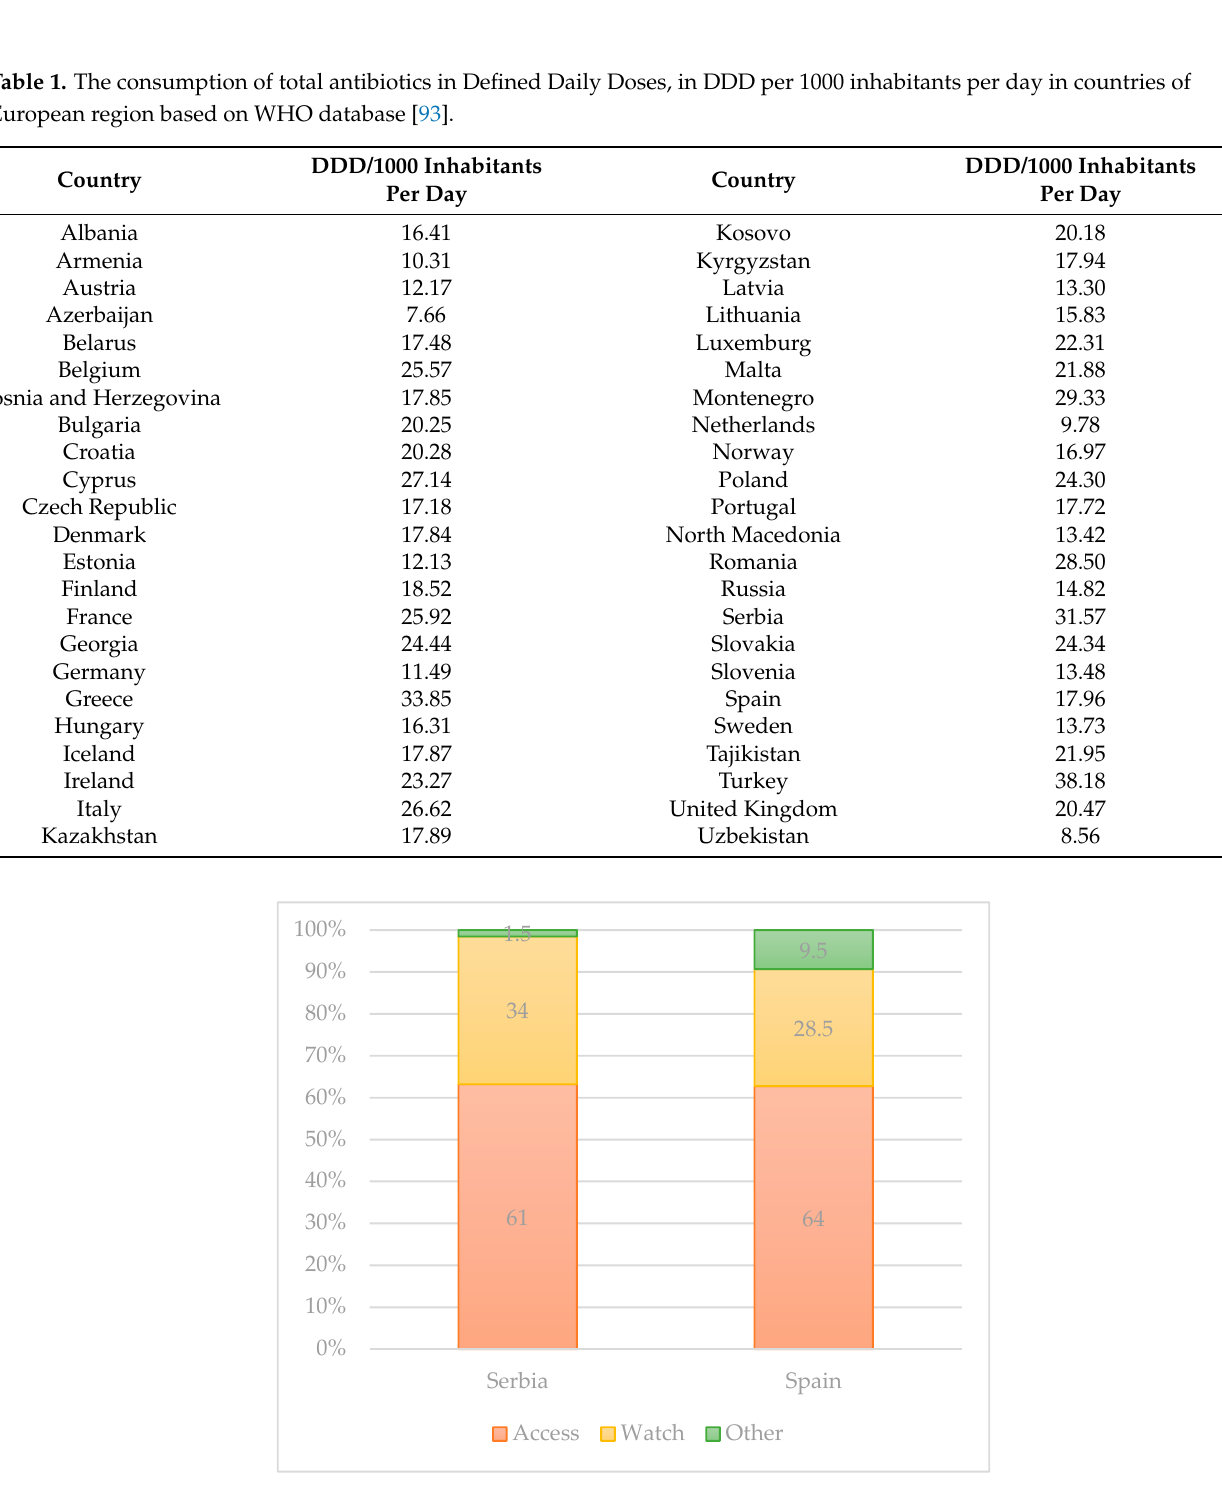
Figure 1. Proportional consumption of antibiotics by AWaRe categorization, % [93,96].